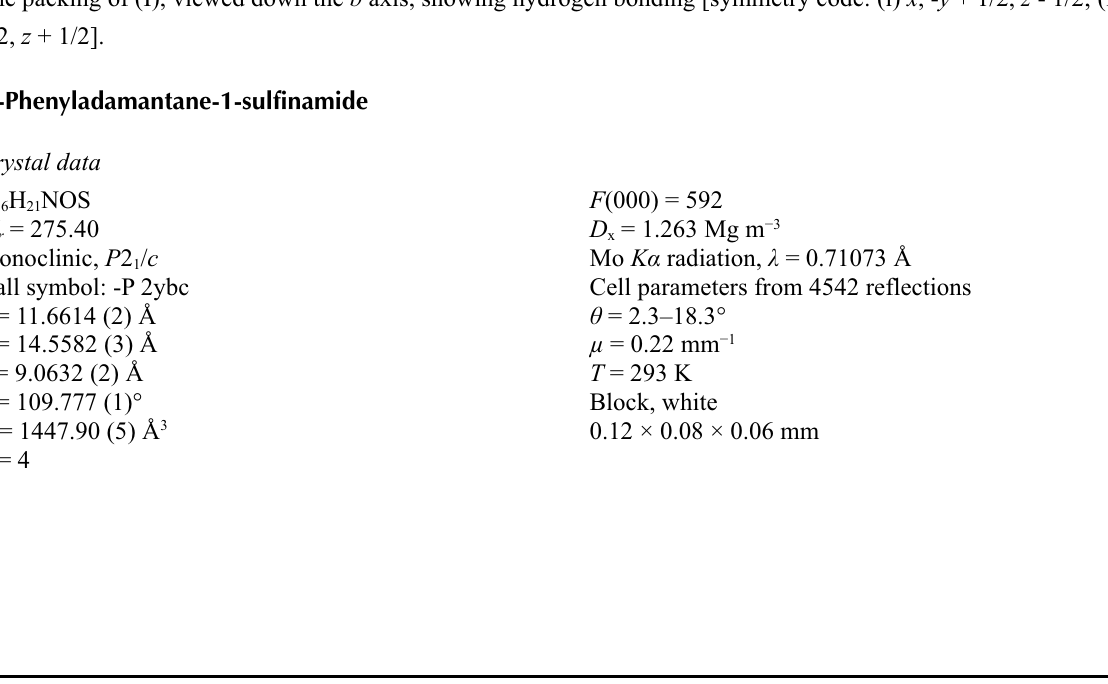
The packing of (I), viewed down the b axis, showing hydrogen bonding [symmetry code: (i) x , - y + 1/2, z - 1/2; (ii) x , - y + 1/2, z +